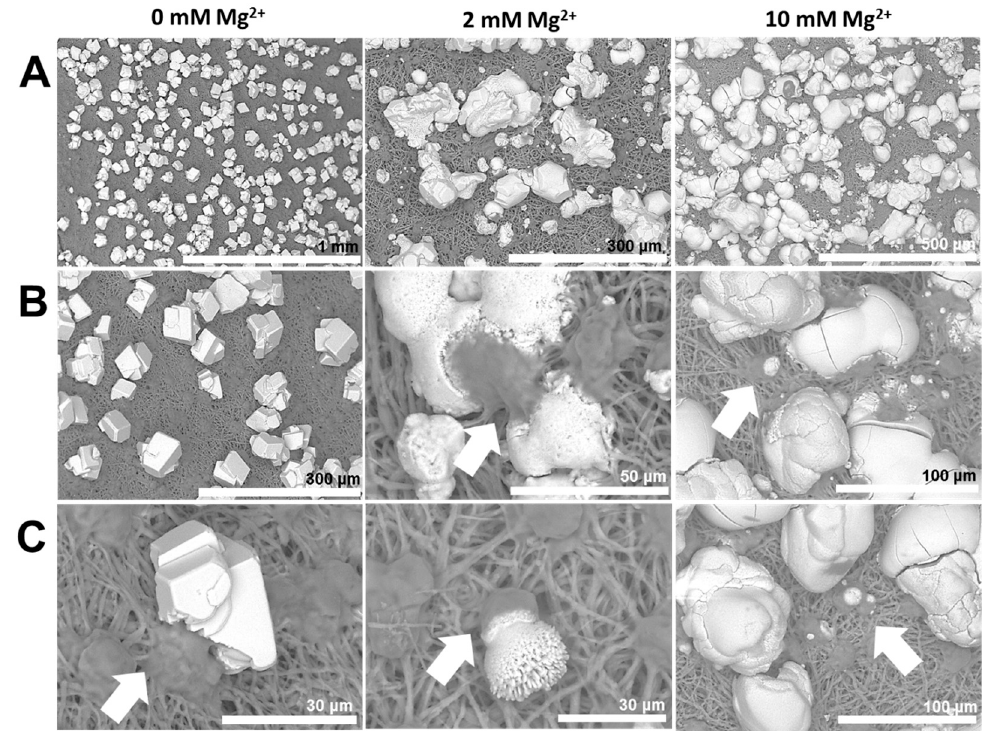
Figure 12. Representative SEM images of the outer surfaces of egg shell membranes mineralized in the presence of poly(aspartic acid) (50 ppm) and different Mg 2+ contents. Arrows indicate mammillae-associated crystals.